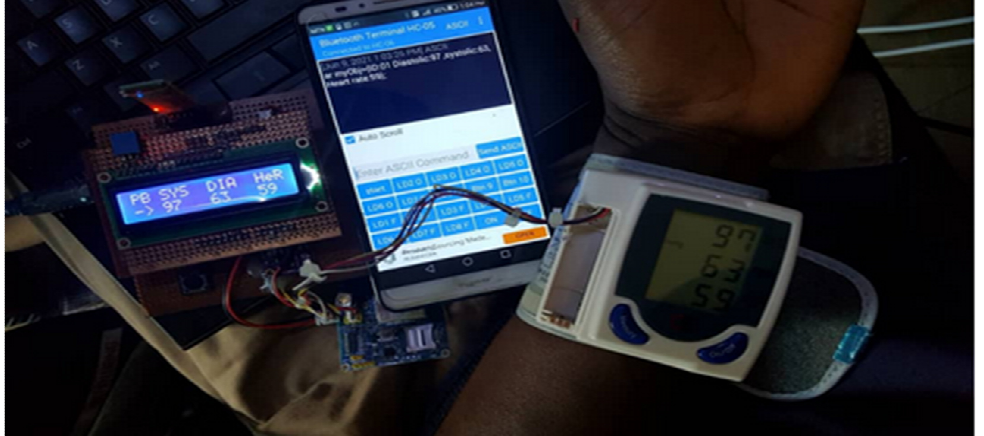
Figure 5. Confirmation of the correct data transmission.